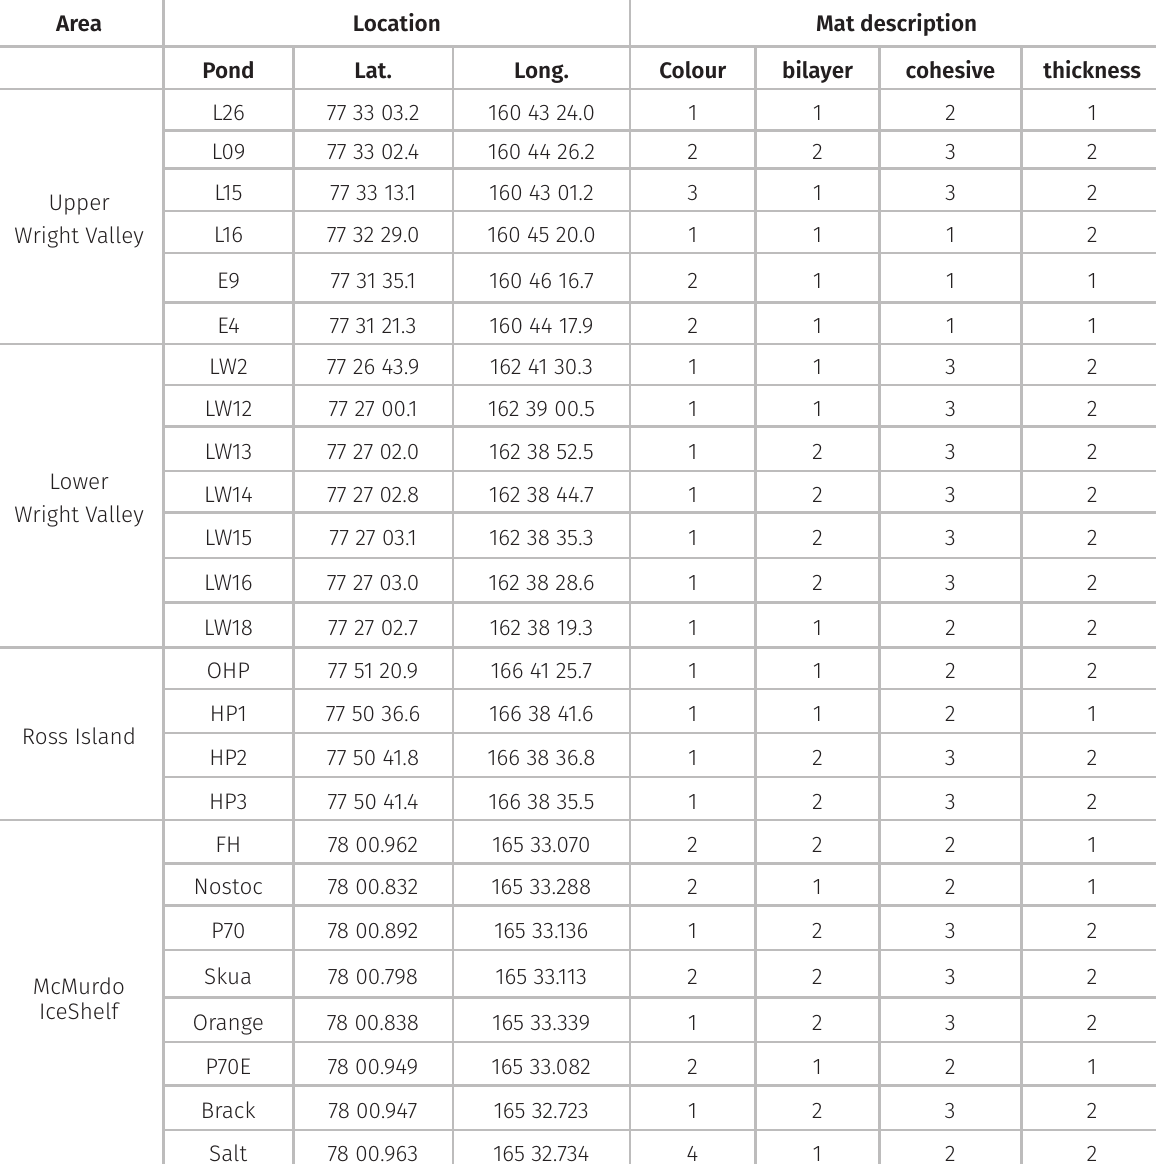
Table I. Locations of study sites and mat description.